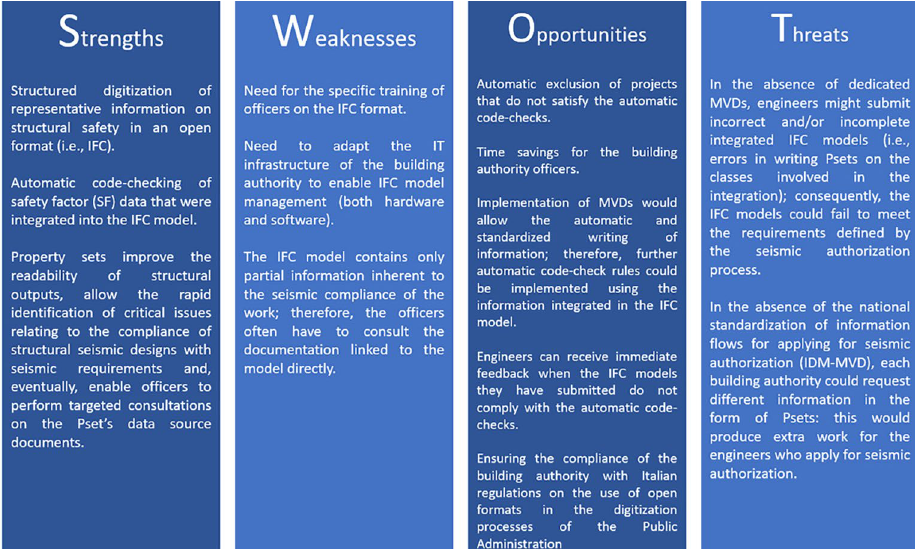
Figure 13. SWOT analysis conducted by the building authority of Avellino on using an integrated IFC model to check compliance with seismic